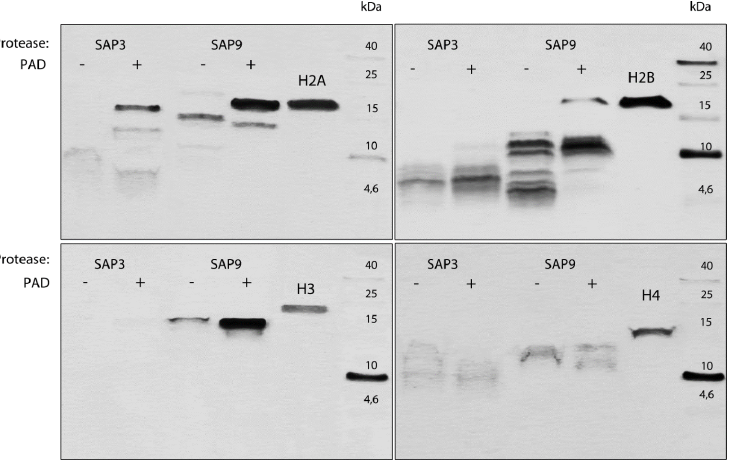
Figure 9. The influence of histone citrullination on the progress of histone degradation by C. albicans aspartic proteases. Unmodified ( − ) and deiminated histones (+) were treated with selected, recombinant aspartic proteinases (Saps, 6 nM) at a 1:1000 enzyme:substrate molar ratio (pH 5, 37 °C, 1 h). The reaction was stopped with pepstatin A (10 µM). The degradation profile was analyzed using SDS-PAGE in the Schägger von Jagov system with silver staining after glutaraldehyde fixation for the protein band visualization, and the representative result of three experiments is presented.